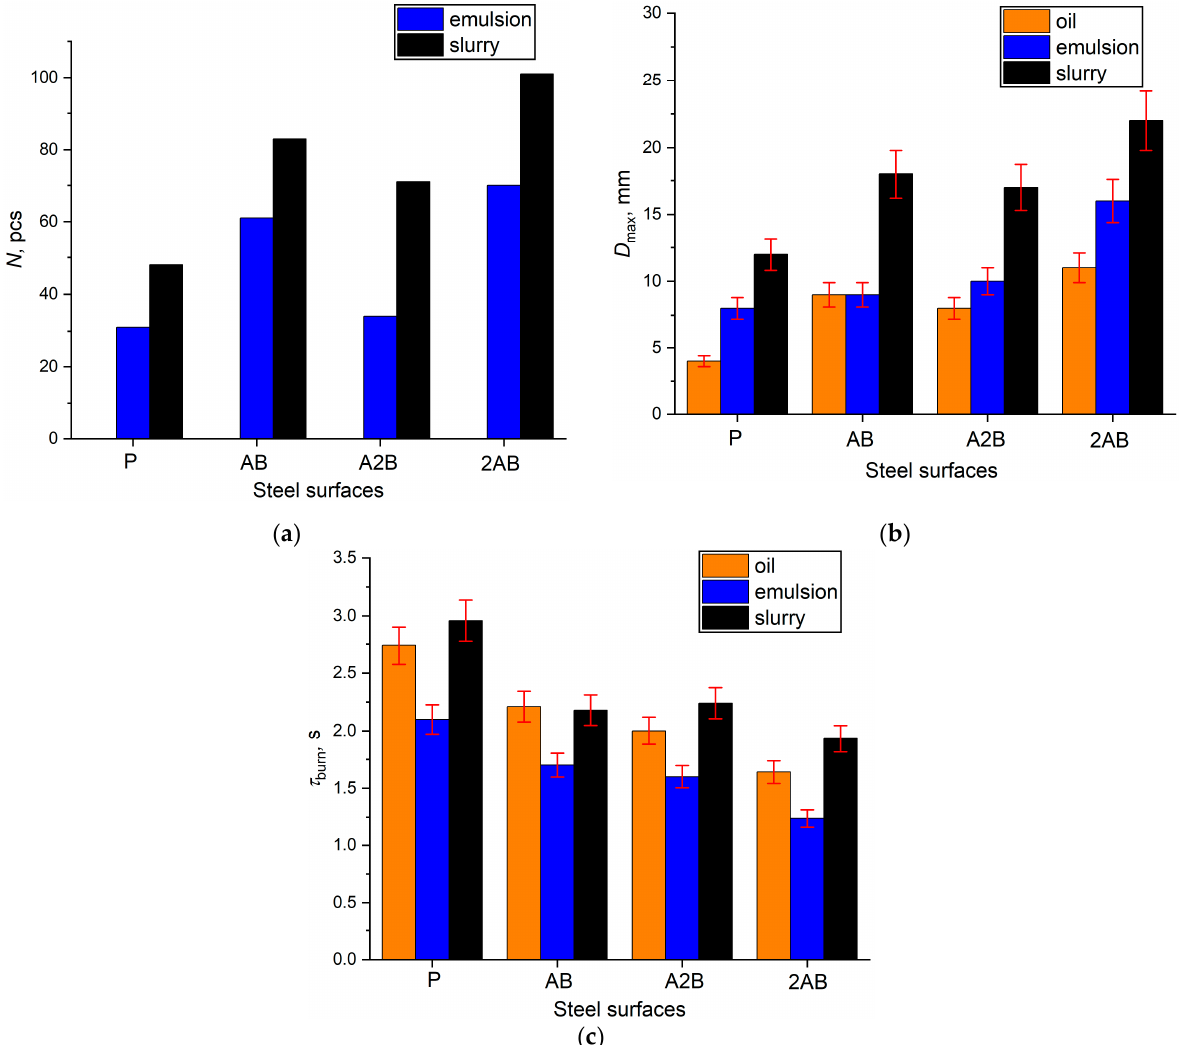
Figure 10. The number of puffing initiations ( a ), the maximum size of the burnout region ( b ), and the time of complete burnout ( c ) of liquid fuels under a conductive heat supply to the P, AB, A2B, and 2AB heating surfaces.